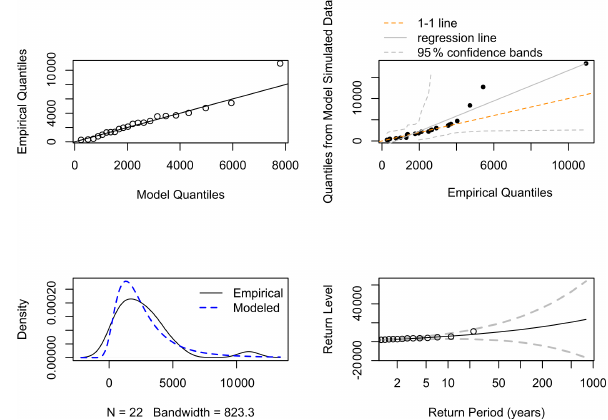
Figure C1. Generalized extreme value distribution modelled with the “exTremes” R package on the sediment discharge time series (22 hydrologic years) at the water treatment plant of the Radicatel catchment.